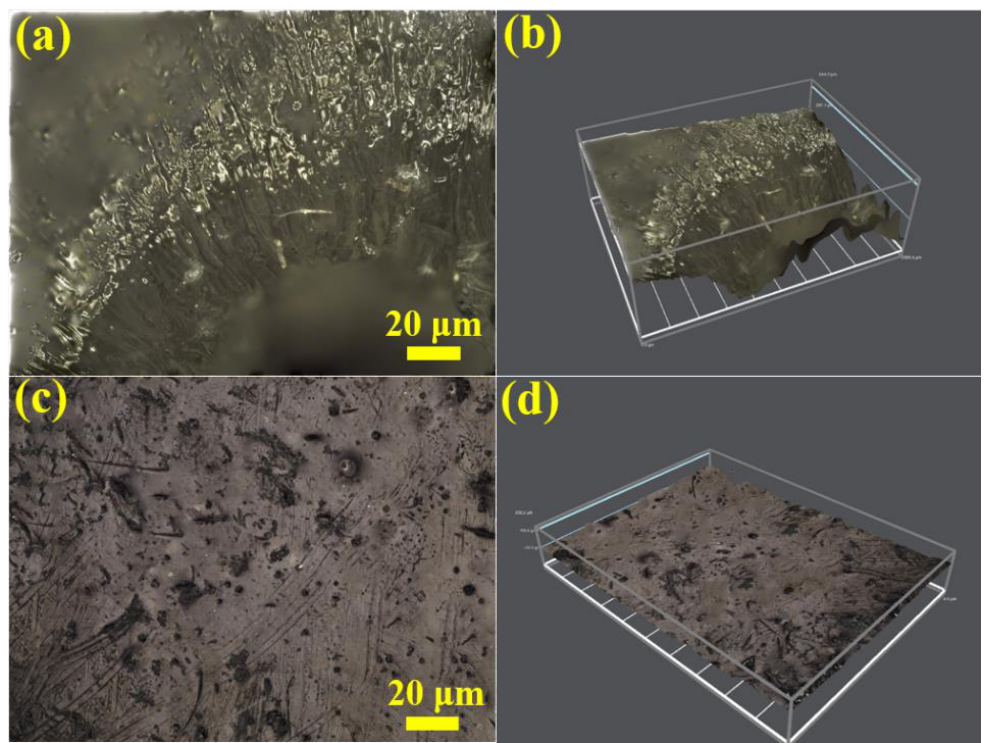
Figure 9. ( a , c ) Ultra-depth of field 3D microscopy images of ( a ) pure PUE and ( c ) A-WS 2 @MWCNTs/PUE surface, and ( b , d ) 3D topography images corresponding to the ( a ) pure PUE and ( c ) A-WS2@MWCNTs/PUE.